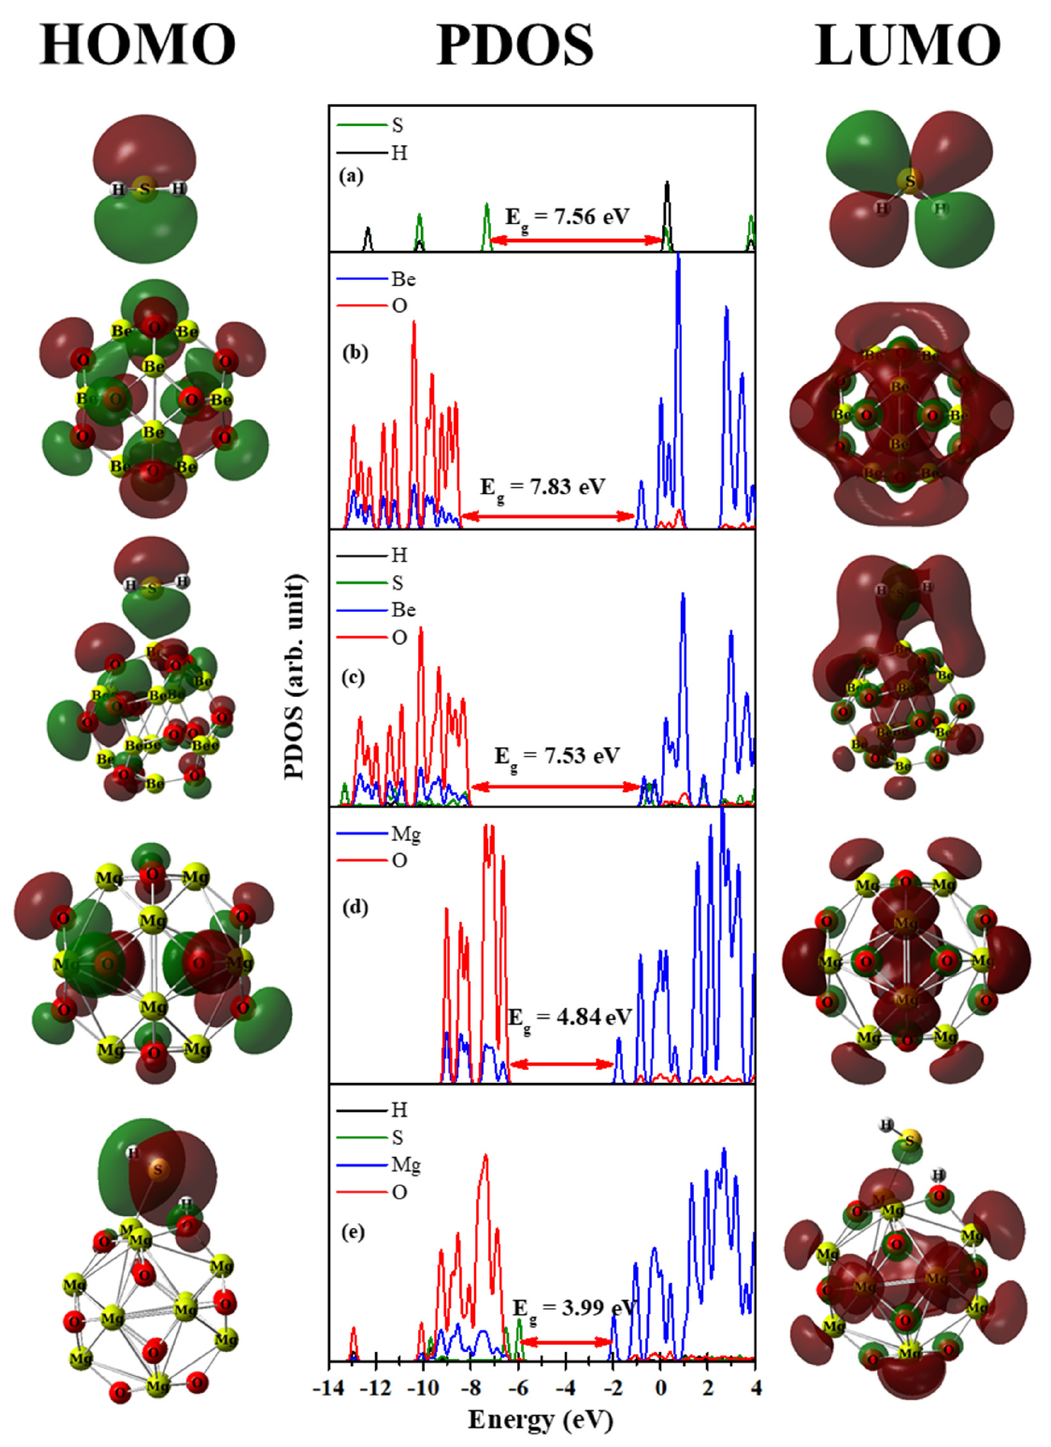
Figure 7. HOMO, PDOS, LUMO for ( a ) H 2 S, ( b ) Be 12 O 12 , ( c ) H 2 S/Be 12 O 12 , ( d ) Mg 12 O 12 , and ( e ) H 2 S/Mg 12 O 12 complexes.